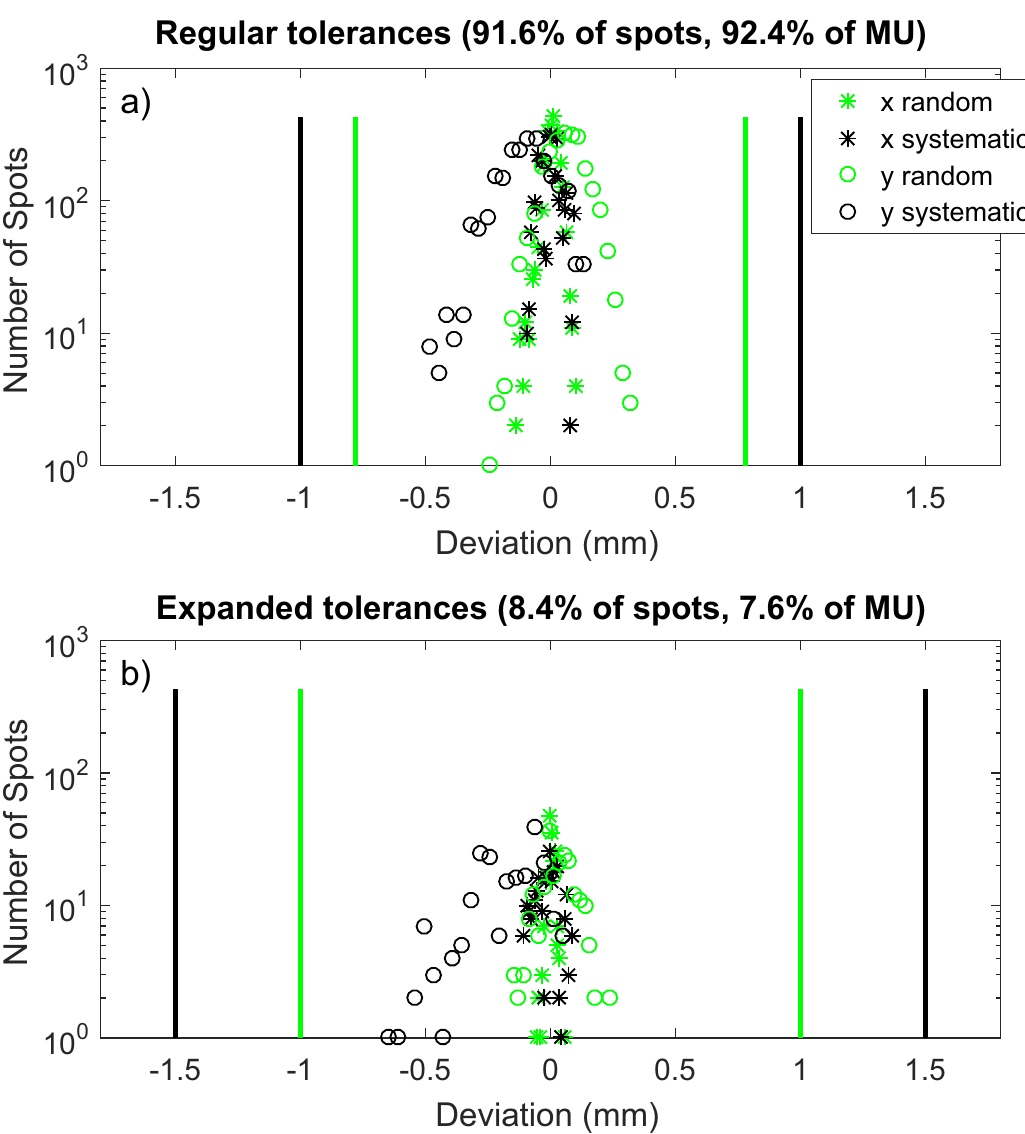
Fig 4. Projected spot position deviation histograms. The systematic and random components of the error (Eqs 1 and 2) are shown on log-linear histograms. Spots subject to regular tolerances (a) are separated from those governed by expanded tolerances